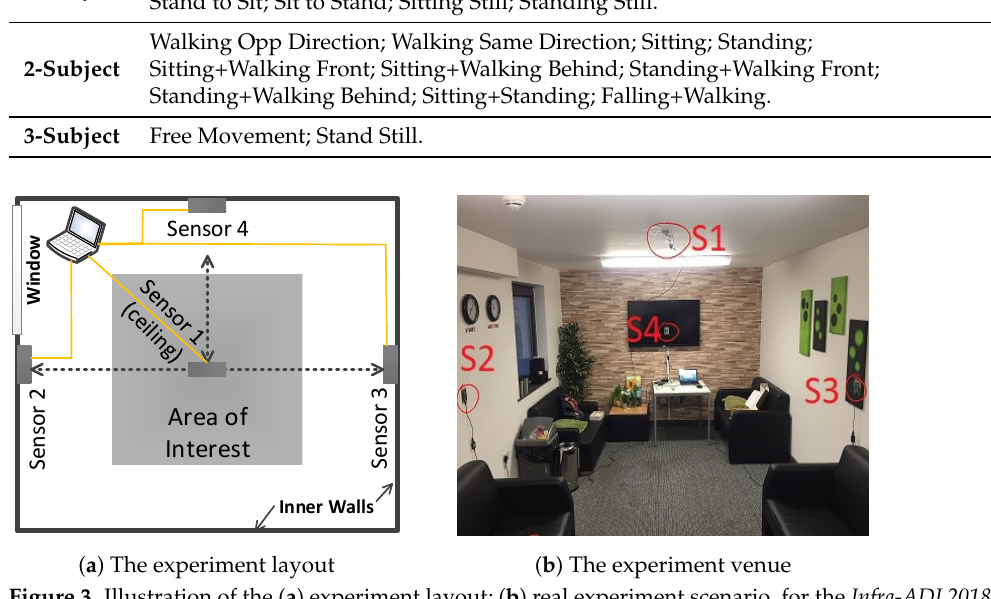
Figure 3. Illustration of the ( a ) experiment layout; ( b ) real experiment scenario, for the Infra-ADL2018 dataset, where S1, S2, S3, and S4 refer to Sensor-1, Sensor-2, Sensor-3, and Sensor-4